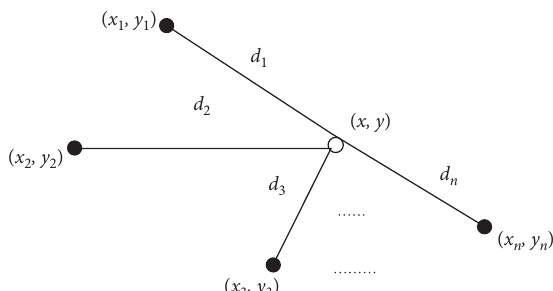
Figure 2: Classic RSSI position